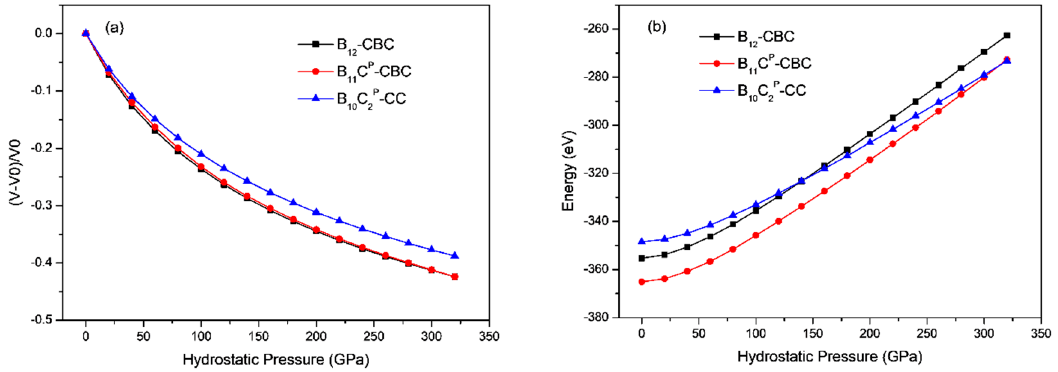
Figure 2. ( a ) The volume strain vs. hydrostatic pressure ( b ) the total energy vs. hydrostatic pressure in B 12 –CBC, B 11 C P –CBC and B 10 C 2P –CC configurations. The volume strain and total energy varies continuously .